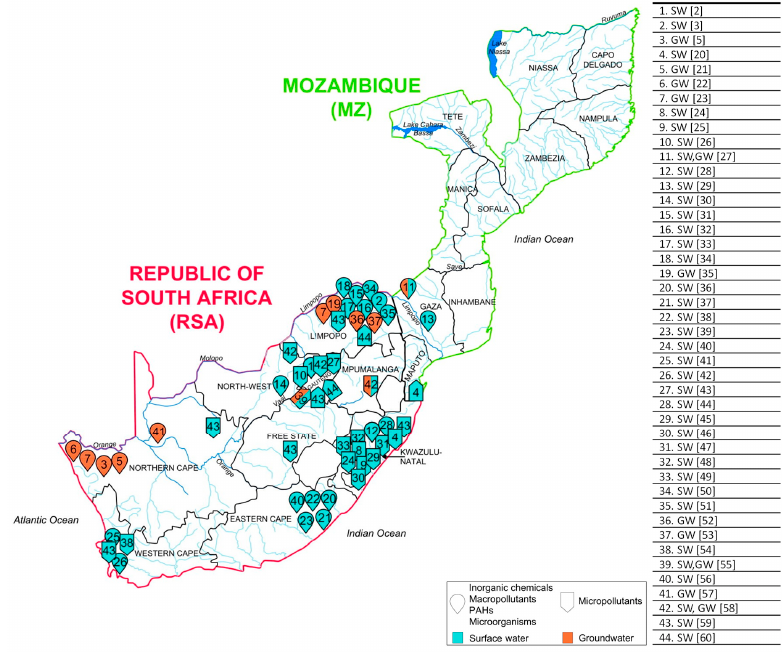
(macropollutants/inorganic chemicals/PAHs/microorganisms or micropollutants) and the corresponding references